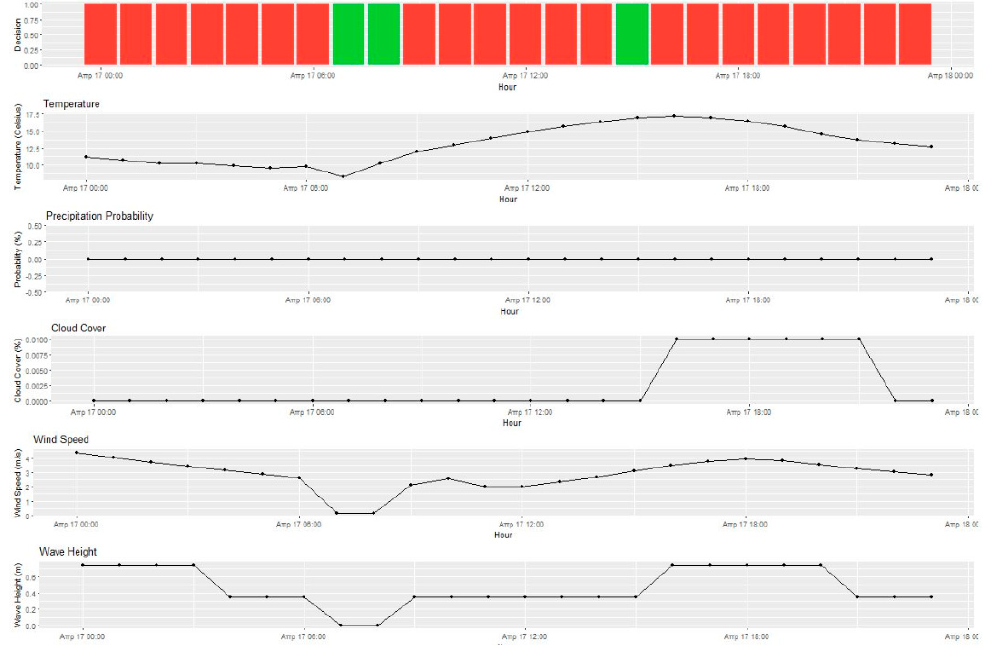
Figure 3. Result of UAS Toolbox on a selected day, green bars refer to optimal flight windows on an hourly basis.